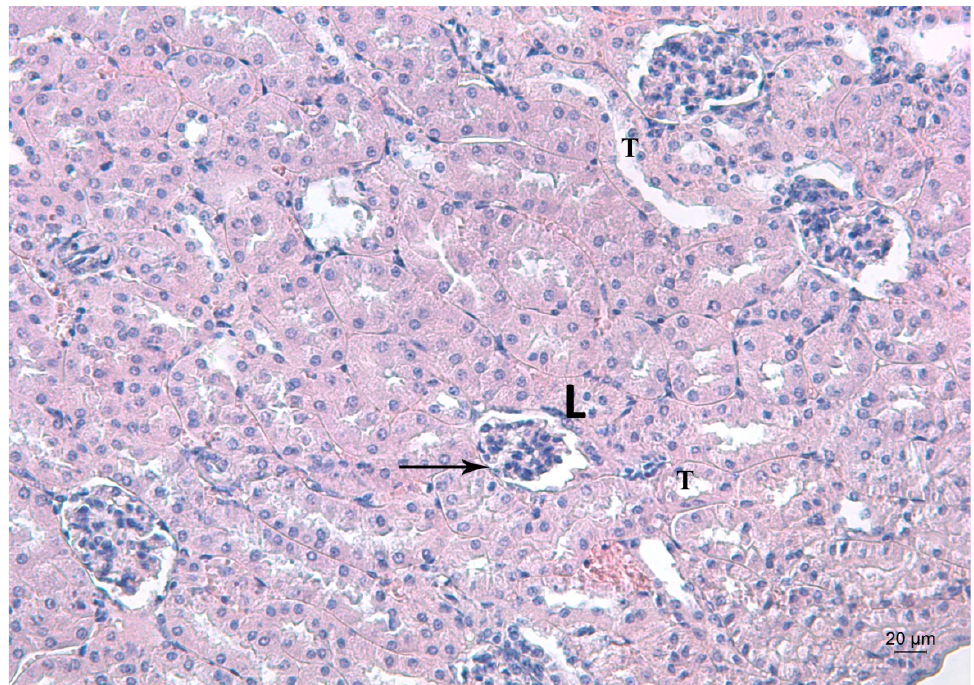
Figure 3. Representative photomicrograph of a kidney section of a control mouse. Arrow denotes the renal glomerulus. HE staining, ×200.